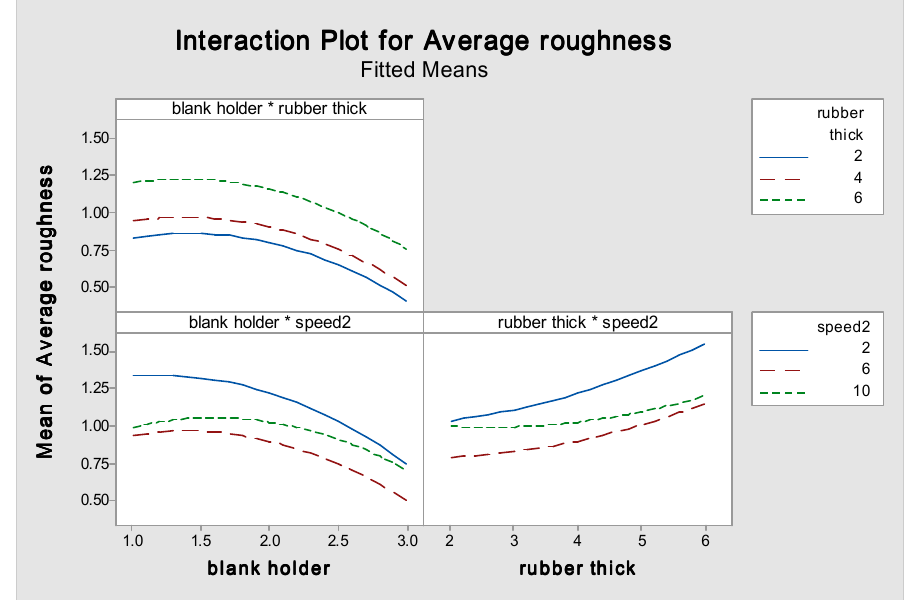
Fig. 10. The relationship of response value with respect to process variables.